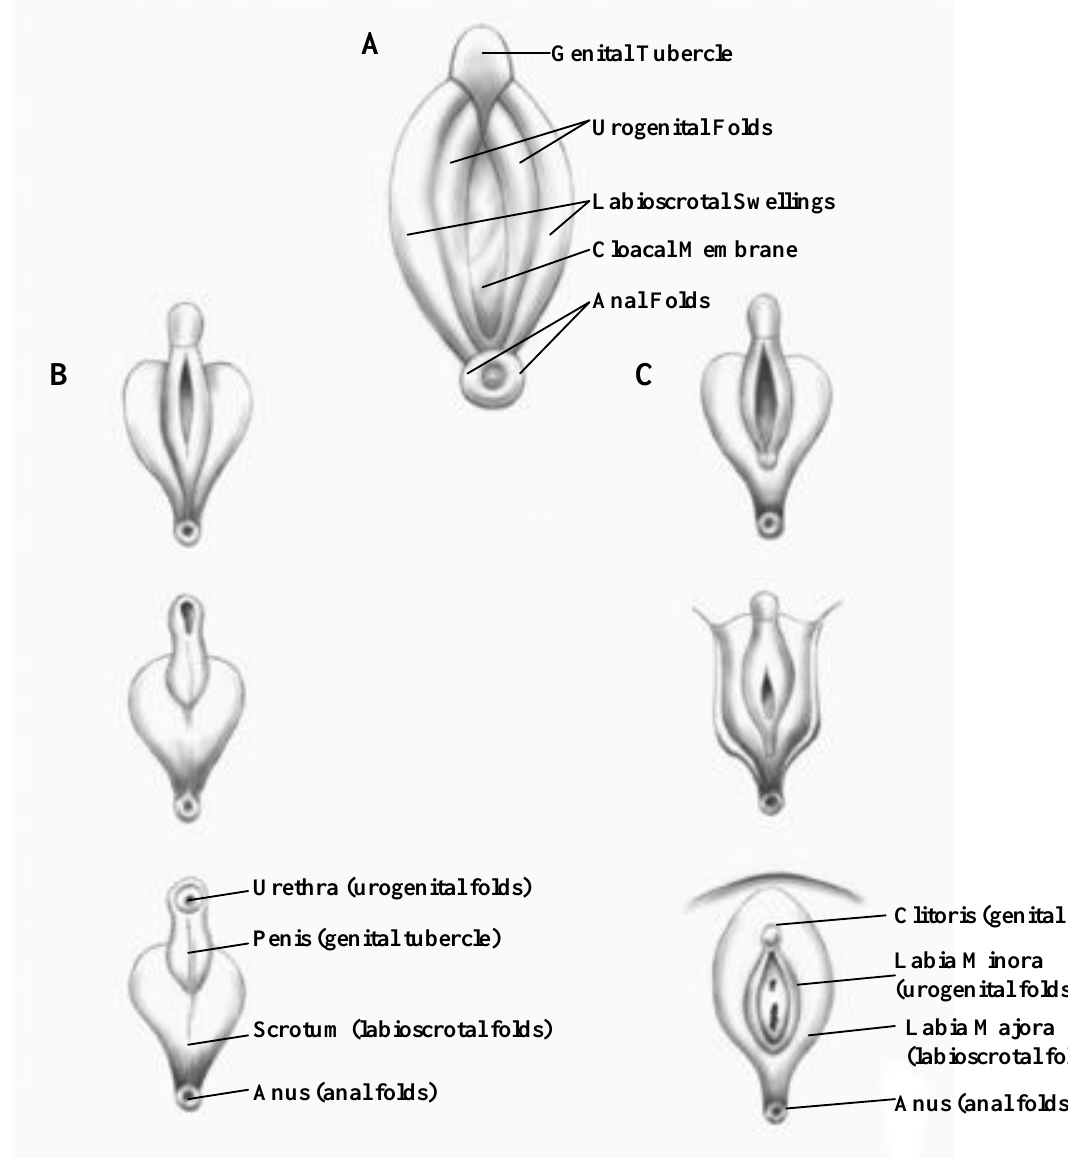
Under the influence of androgens, in males the mesoderm of the genital tubercle enlarges to become the corpora cavernosa and glans penis. The endoderm tubularizes in a proximal to distal direction to form the penile urethra. The ectoderm develops into the penile skin and prepuce, which begins formation at 8 weeks. There is some debate as to whether the distal urethra is formed from tubularization of the endoderm, as with the proximal urethra, or from canalization of the ectoderm